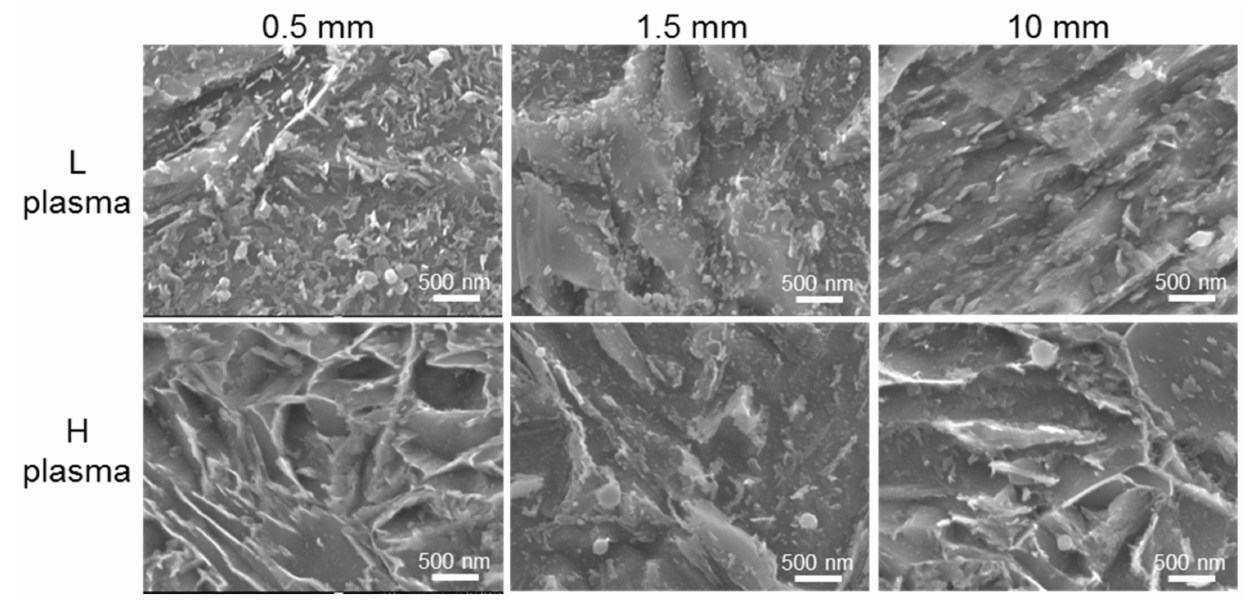
Figure 10. SEM images of fine precipitates in Steels L and H cut using plasma cutting method: left to right, at the cut edge, point of minimum HV, and far away from the cut edge (base plate). Table 4. Average parameters of fine Ti-rich particles studied with SEM (at 10 mm away from the cut edge no heat effect was observed, therefore the microstructure at this position was considered as the